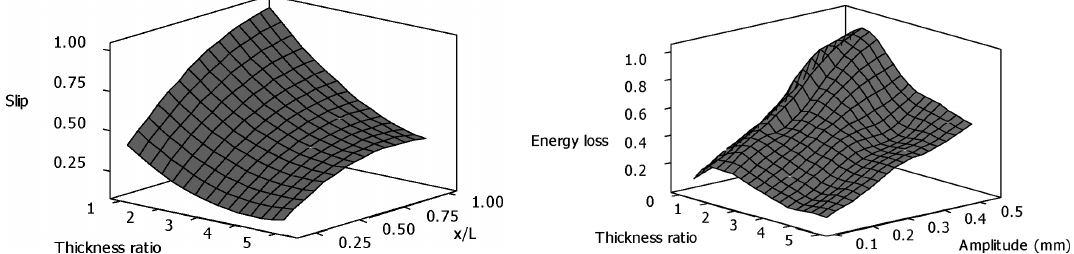
Fig. 7. Surface plot of relative slip with axial position and Fig. 8. Surface plot of energy loss with amplitude and thickness ratio. thickness